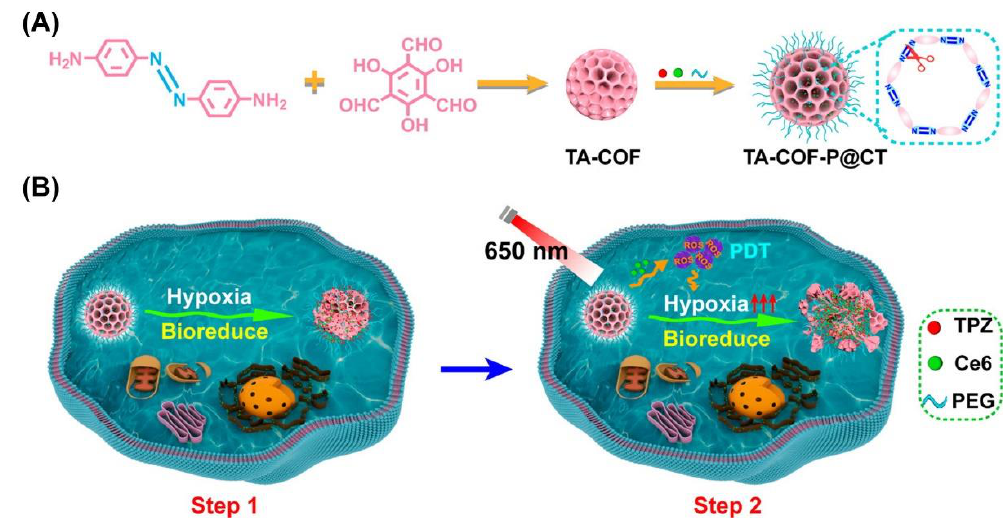
Figure 7. ( A ) Schematic illustration for the synthesis of TA-COF and TA-COF-P@CT. ( B ) Schematic illustration of two-step photo-activated hypoxia-responsive drug delivery toward cancer treatment. Reproduced from [46] with permission, copyright 2021, American Chemical Society.